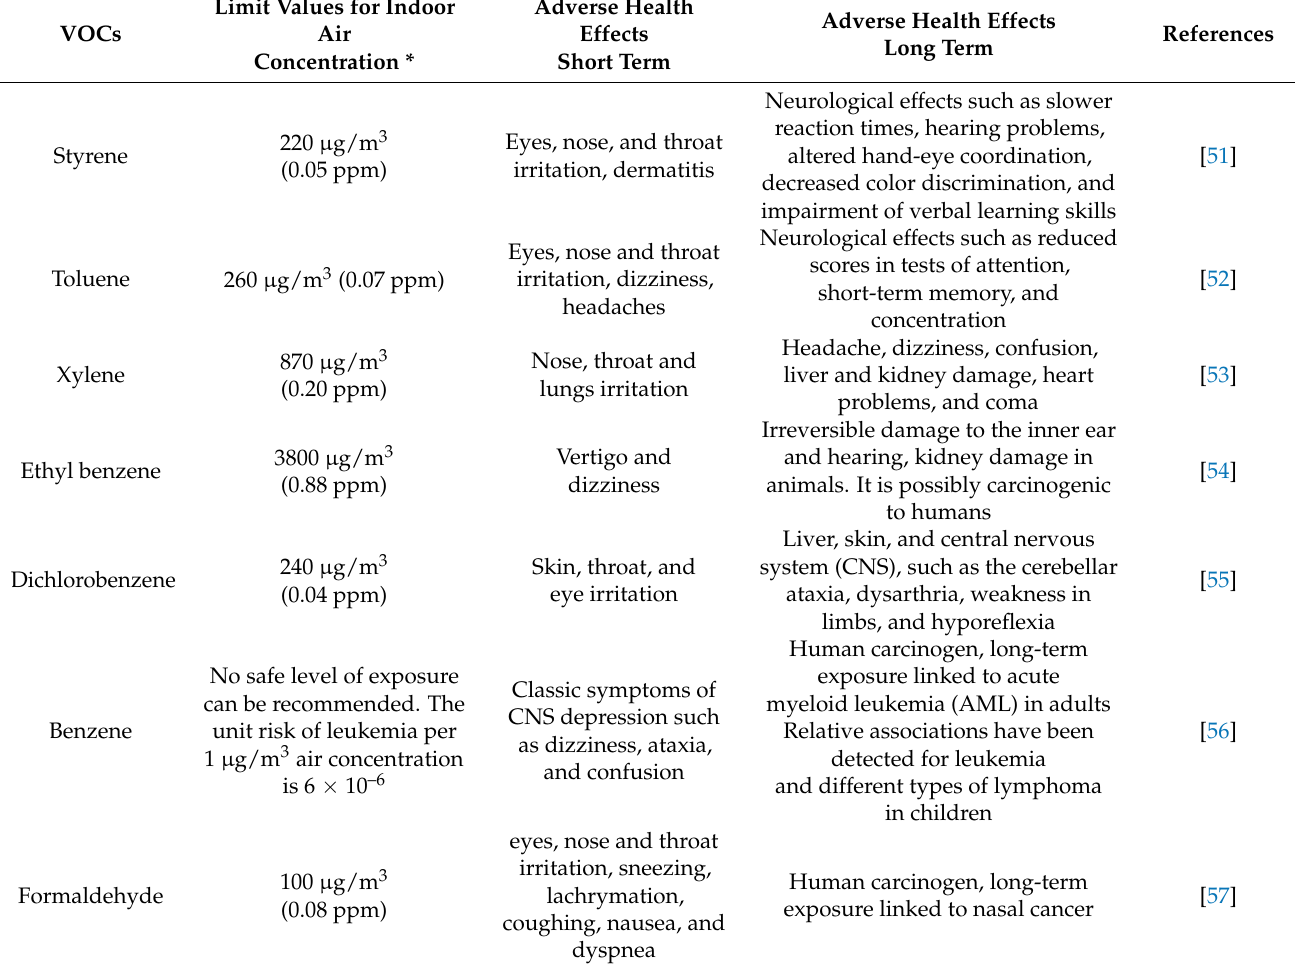
Table 2. Allowable values and health effects of VOCs emitted from